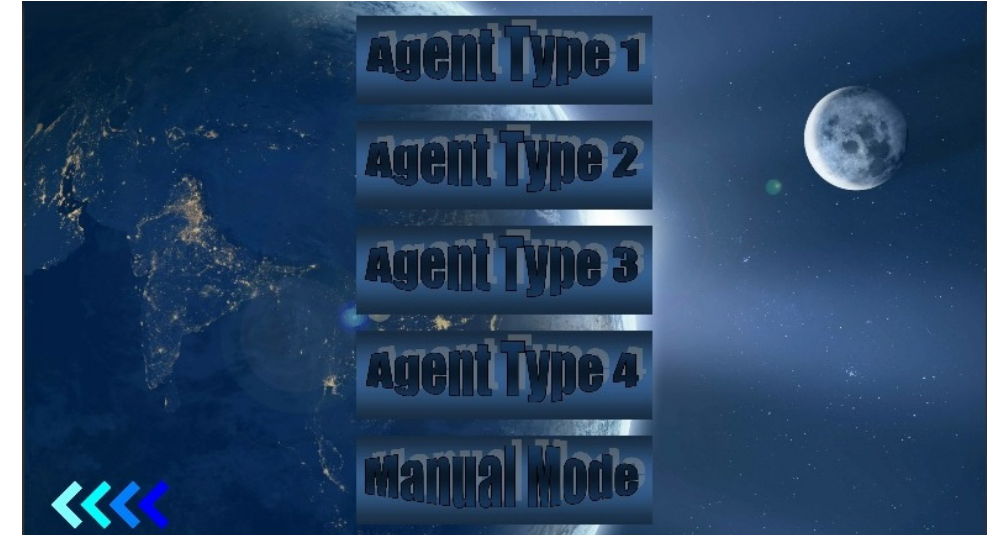
Figure 1. The operation modes page of the AViLab system’s GUI offers to start one of the developed agents or enter a manual mode.